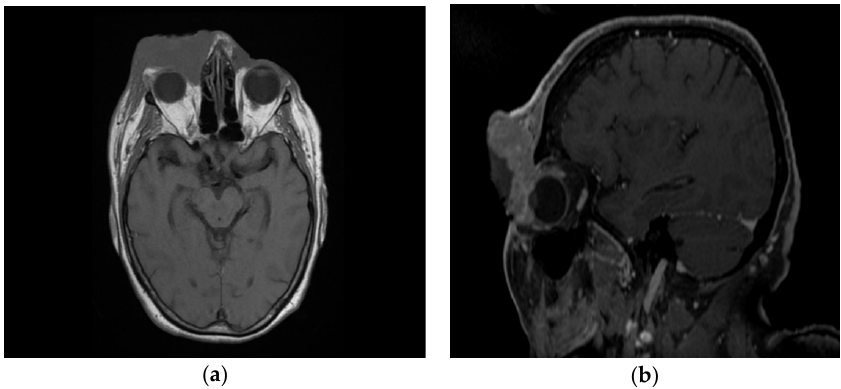
Figure 4. Ax T1 FSE non-enhanced ( a ) and sagittal T1 FSE contrast-enhanced with fat-saturation sequence ( b ). Inhomogeneous enhancement of the lesion, with superficial tissue origin and invasion in the right